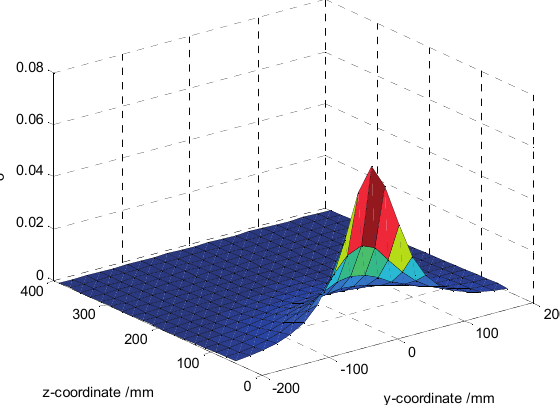
Figure 7. The homogeneity of the spatial sensitivity.